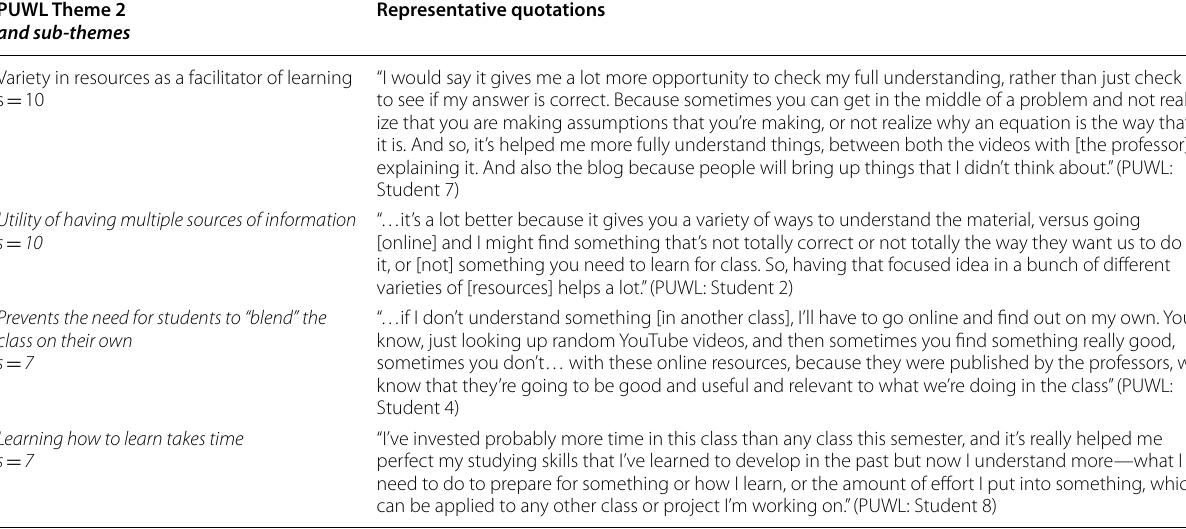
Representative quotations